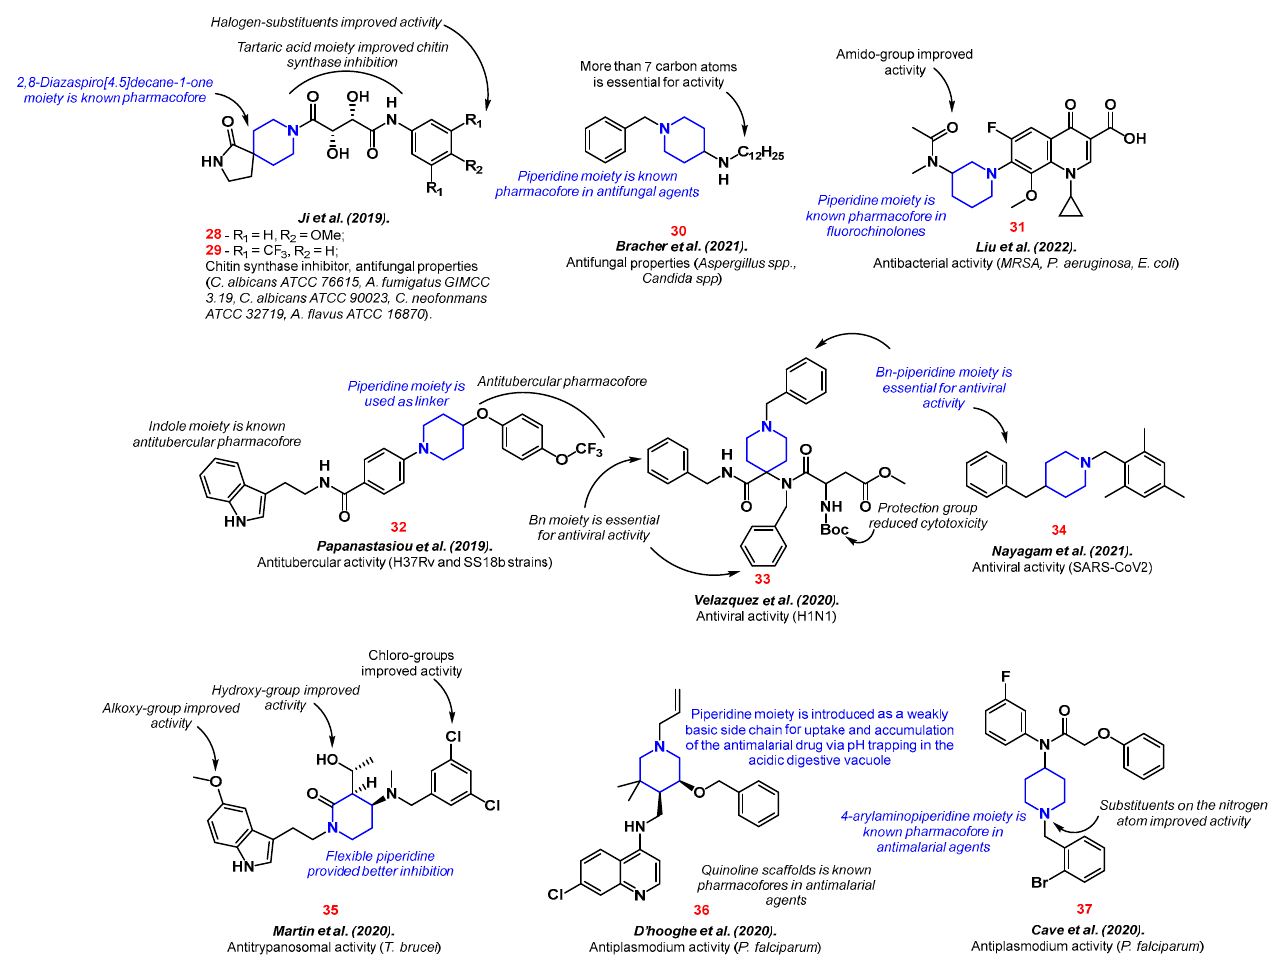
Figure 7. Piperidine derivatives with antimicrobial activity [260,261,263–269]. Opioid receptors are divided into four similar types: µ ‑opioid (MOR), δ ‑opioid (DOR), κ ‑opioid (KOR), and nociceptin/orphanin FQ peptide receptor (NOP) [271,272]. MOR